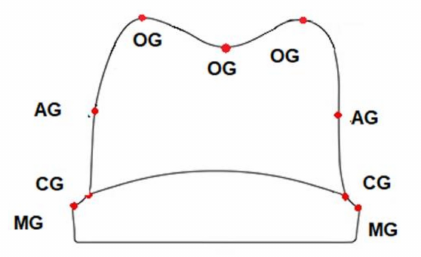
Figure 3. Anatomical distribution of the evaluation points for the replica technique and micro-CT